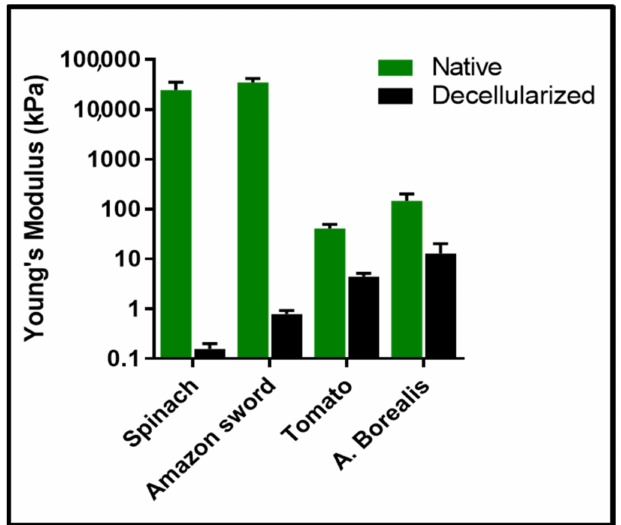
Figure 6. Young’s modulus of vegetal tissues before (native) and after decellularization. Graph reproduced, in part, from Lacombe et al.